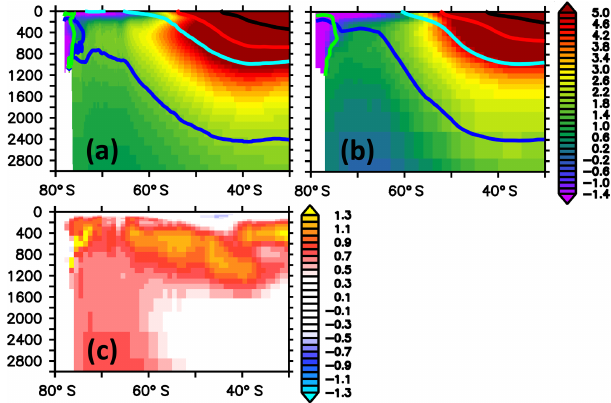
Figure 15. Zonally averaged meridional section of temperature in units of ◦ C. Panel (a) refers to simulated concentrations averaged over the nominal 1993–1998 period of the reference simulation; (b) refers to observed climatological values (WOA09); (c) refers to the difference between simulated and observed values, with blue colors denoting simulated temperatures that are biased low. The thick black, red, cyan, blue and green contours refer to mean densi- ties (Sallée et al., 2013b, their Table 2) of subtropical water, mode water, intermediate water, circumpolar deep water and bottom wa- ter,